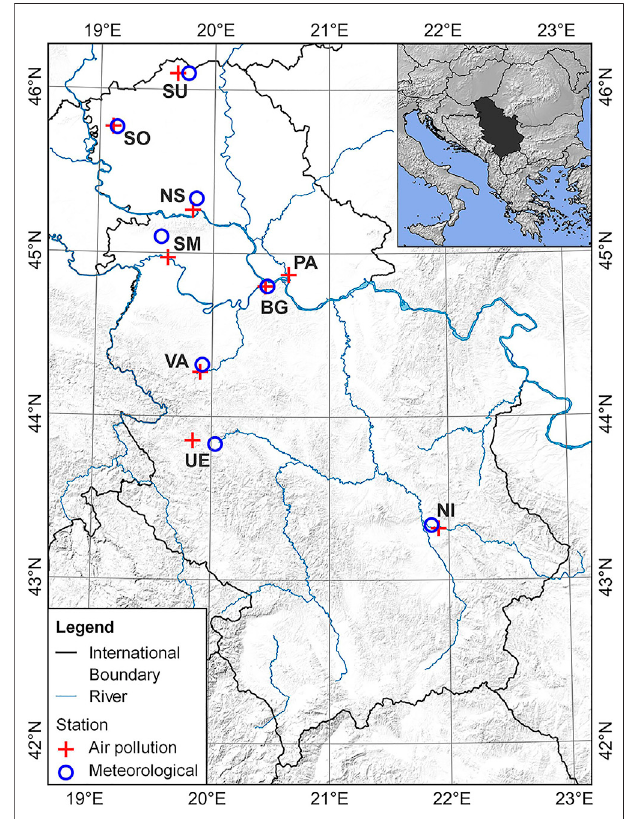
FIGURE 1 | Location of the traf fi c air pollution monitoring and meteorological stations in Serbia used in the